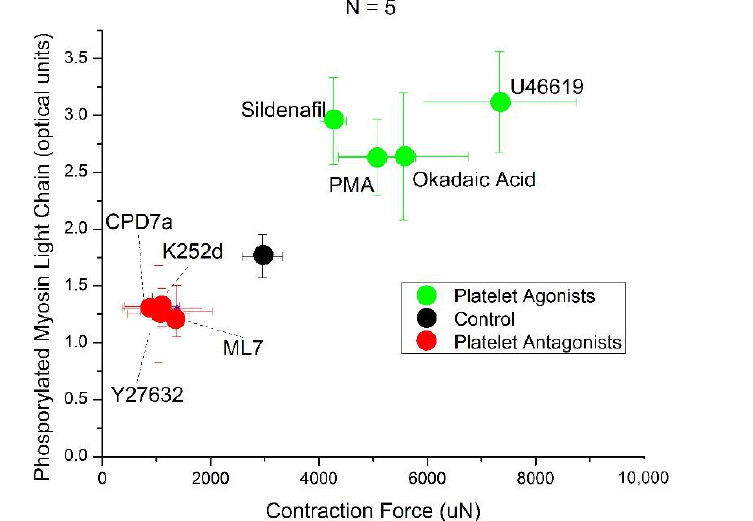
Figure 4. Phosphorylated myosin varies linearly with contraction force. Platelet antagonists shown in red cause decreased levels of phosphorylated myosin and corresponding decreases in platelet contraction force. Platelet agonists shown in green cause increased levels of phosphorylated myosin and increased contraction forces. Each point reflects an average of 5 different volunteers with standard deviation shown for contraction force and phosphorylated myosin. Contraction force varies linearly with phosphorylated MLC with an R squared value of 0.91.